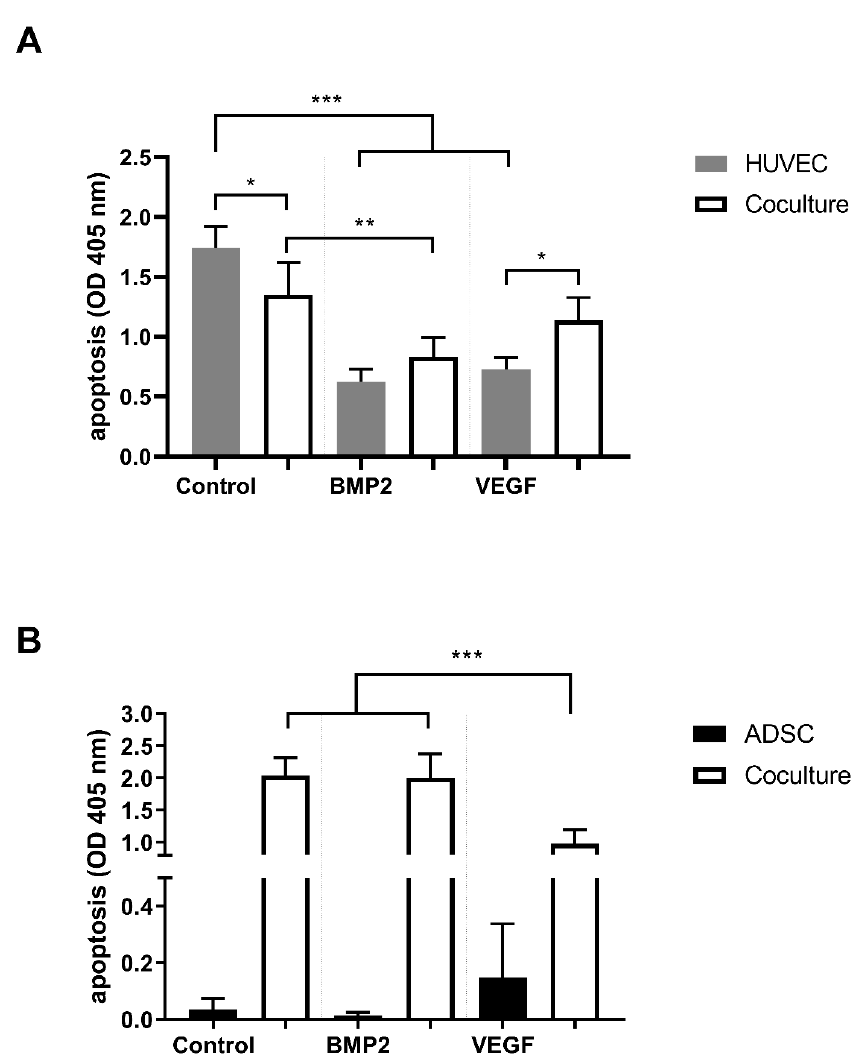
Figure 2. Apoptosis of ADSCs and HUVECs under mono- and coculture conditions. Coculturing reduced apoptosis in the HUVEC control group. Moreover, BMP2 and VEGFA165 reduced apoptosis in the HUVEC monocultures ( A ). VEGFA165 reduced apoptosis in the cocultured ADSCs ( B ). Statistically significant differences between the experimental groups are indicated for * p ≤ 0.05, ** p ≤ 0.01 and *** p ≤ 0.001.